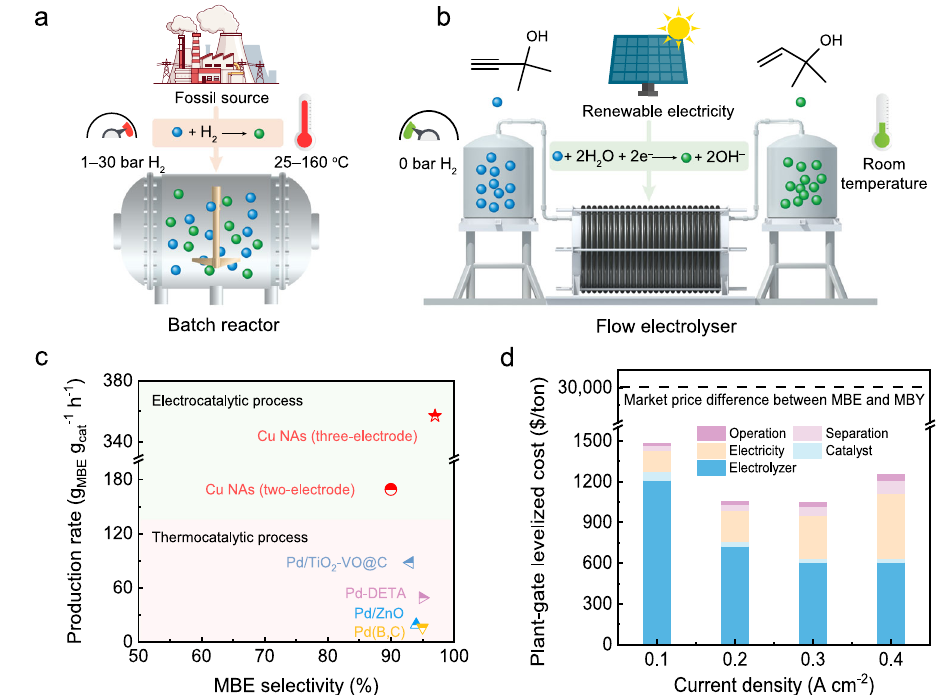
Fig.1|Electrocatalyticsemi-hydrogenationofMBYbyusingrenewableenergy. Schematic illustrations: ( a ) the industrial thermocatalytic process and ( b ) the proposed electrocatalytic process. c Comparison of the thermocatalytic and elec- trocatalyticprocesses. d Breakdownof theplant-gate levelized costpertonforthe